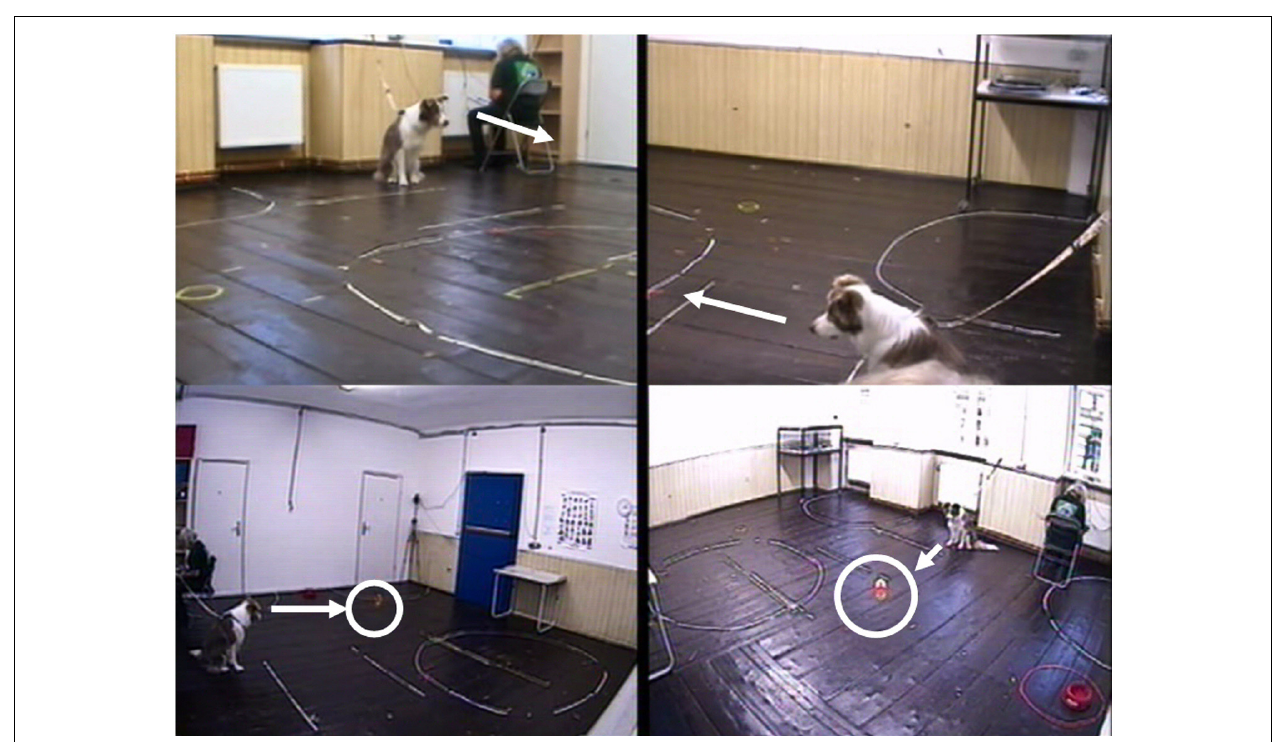
FIGURE 1 | Still video frame from set-up of experiment 1 – Event 1 condition.